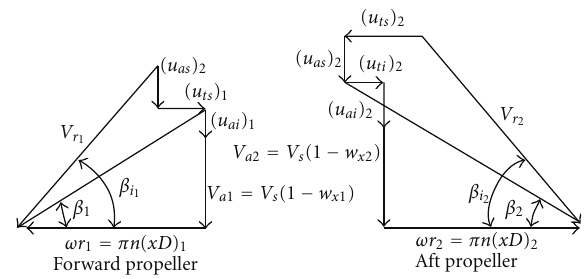
Figure 2: Velocity diagram of inviscid velocities at each blade